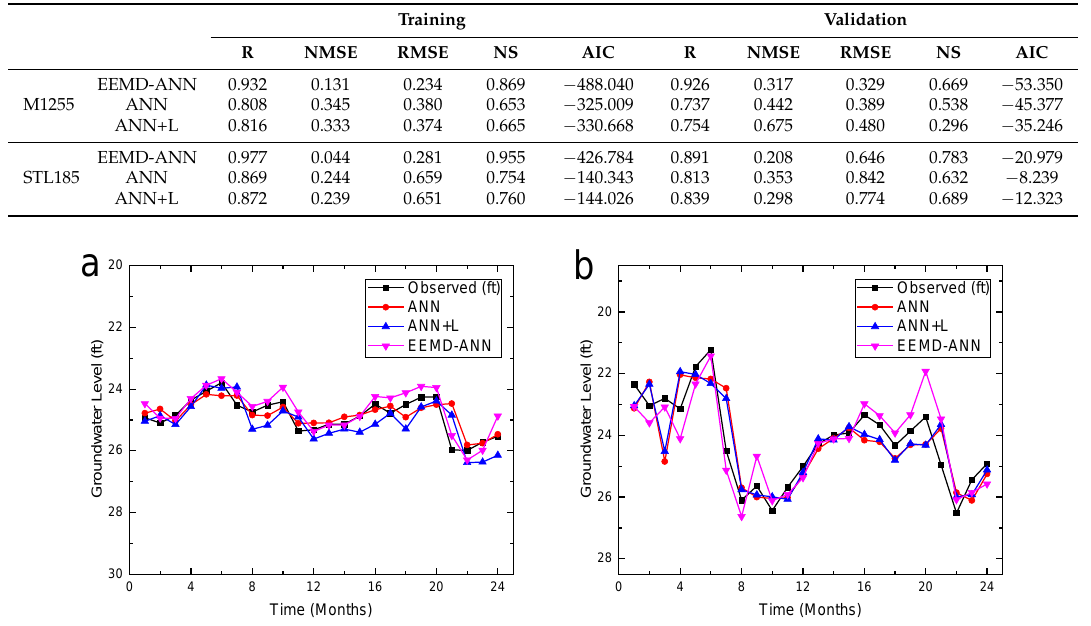
Figure 11. Observed and predicted groundwater level using ANN, ANN+L and EEMD-ANN ( a ) M1255 ( b ) STL185.